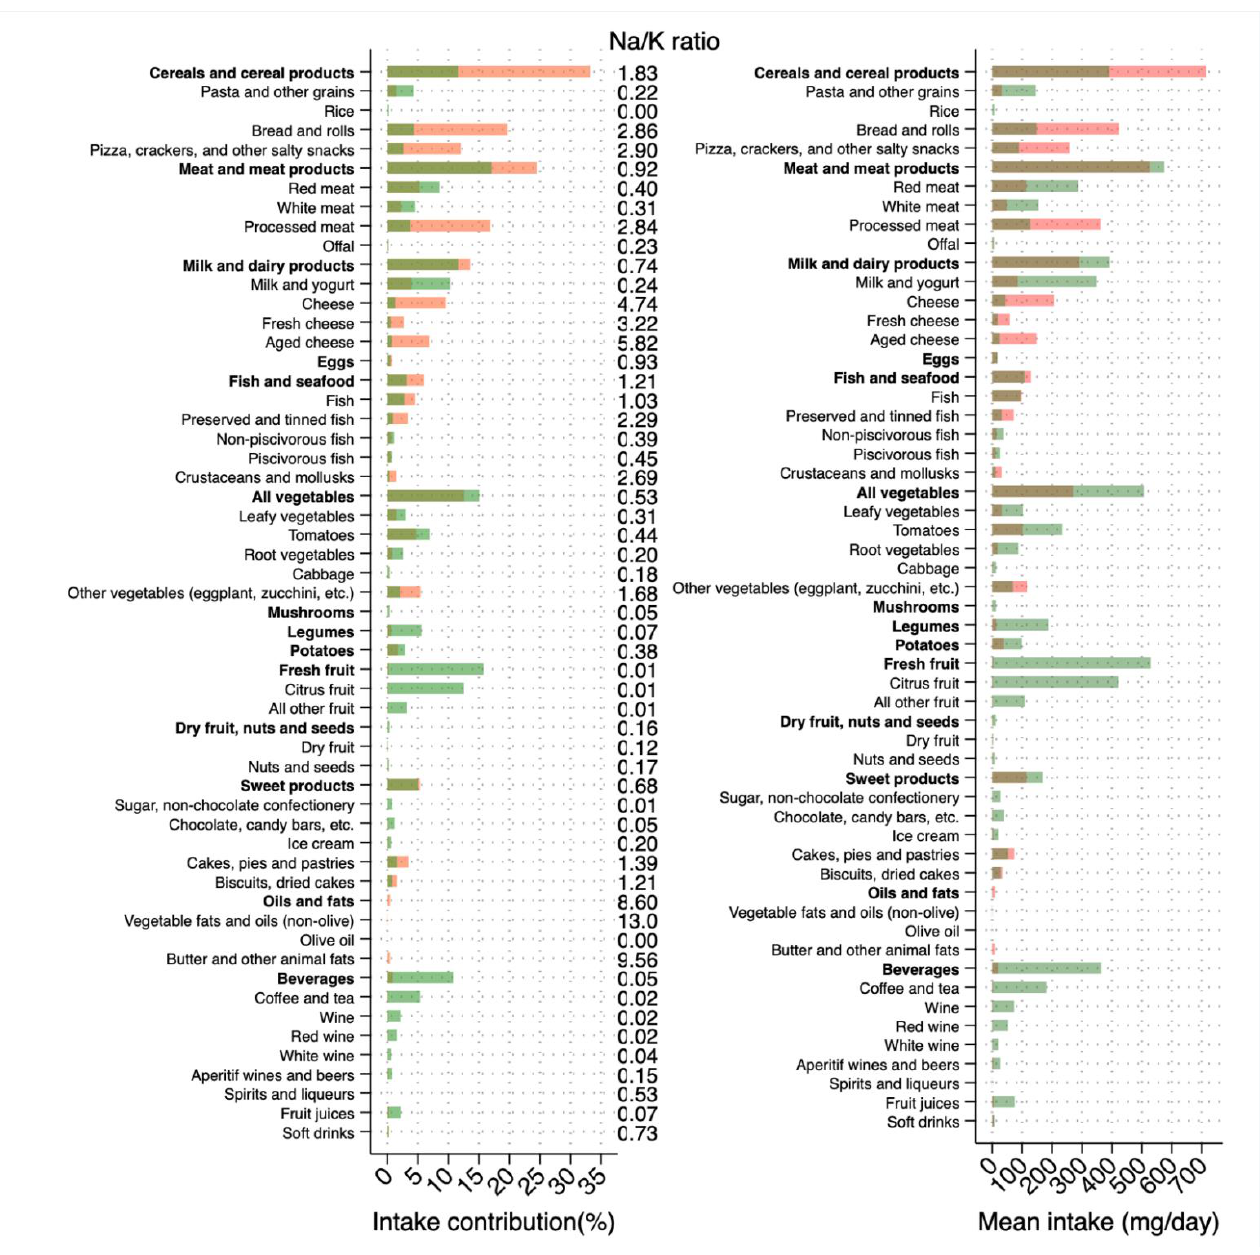
Figure 1. Average level of intake (in mg/day) of sodium and potassium according to food categories, their percentage contribution (in %) and sodium-to-potassium (Na/K) ratio. Light and dark orange bars indicate sodium and light and dark green bars indicate potassium, respectively.